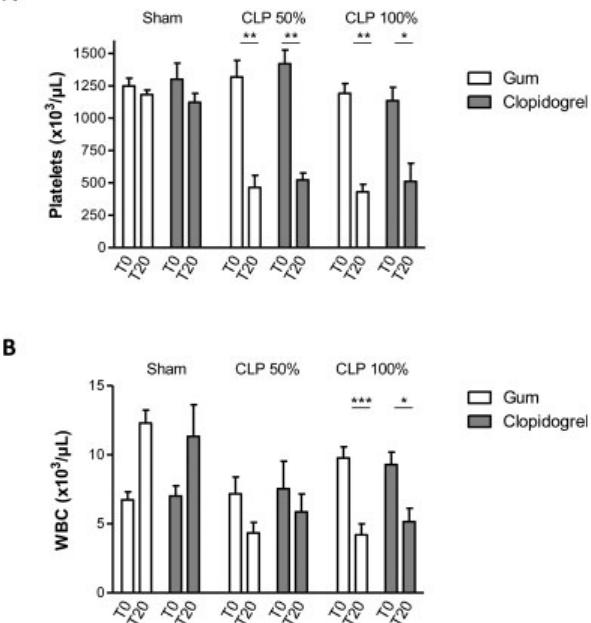
Fig. 2 Clopidogrel treatment does not modify thrombocytopenia during sepsis and septic shock. Circulating platelet counts ((A)) and WBC counts ((B)) in clopidogrel- or vehicle-treated mice, before (T0) and 20hours (T20) after mid- or high-grade form of CLP as compared with sham-surgery. Results are presentedas the mean (cid:4) SEM ( n ¼ 6 – 7, (cid:1)(cid:1)(cid:1) p < 0.001, (cid:1)(cid:1) p < 0.01, (cid:1) p < 0.05, ns p > 0.05). TH Open Vol. 5 No. 3/2021 © 2021. The